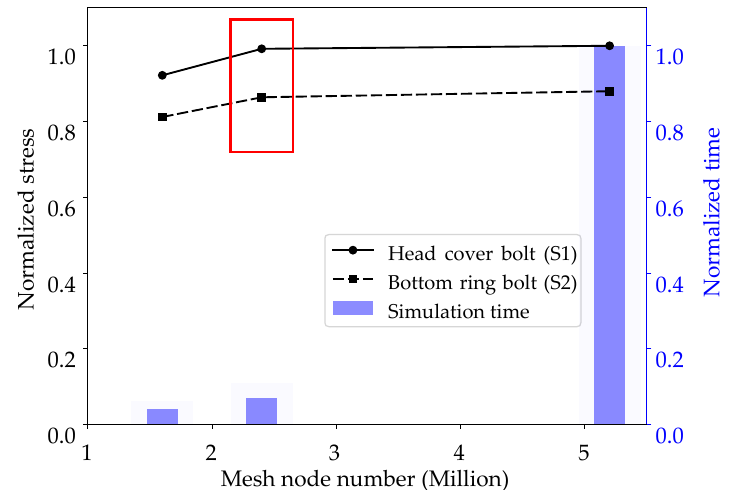
Figure 12. Mesh independence